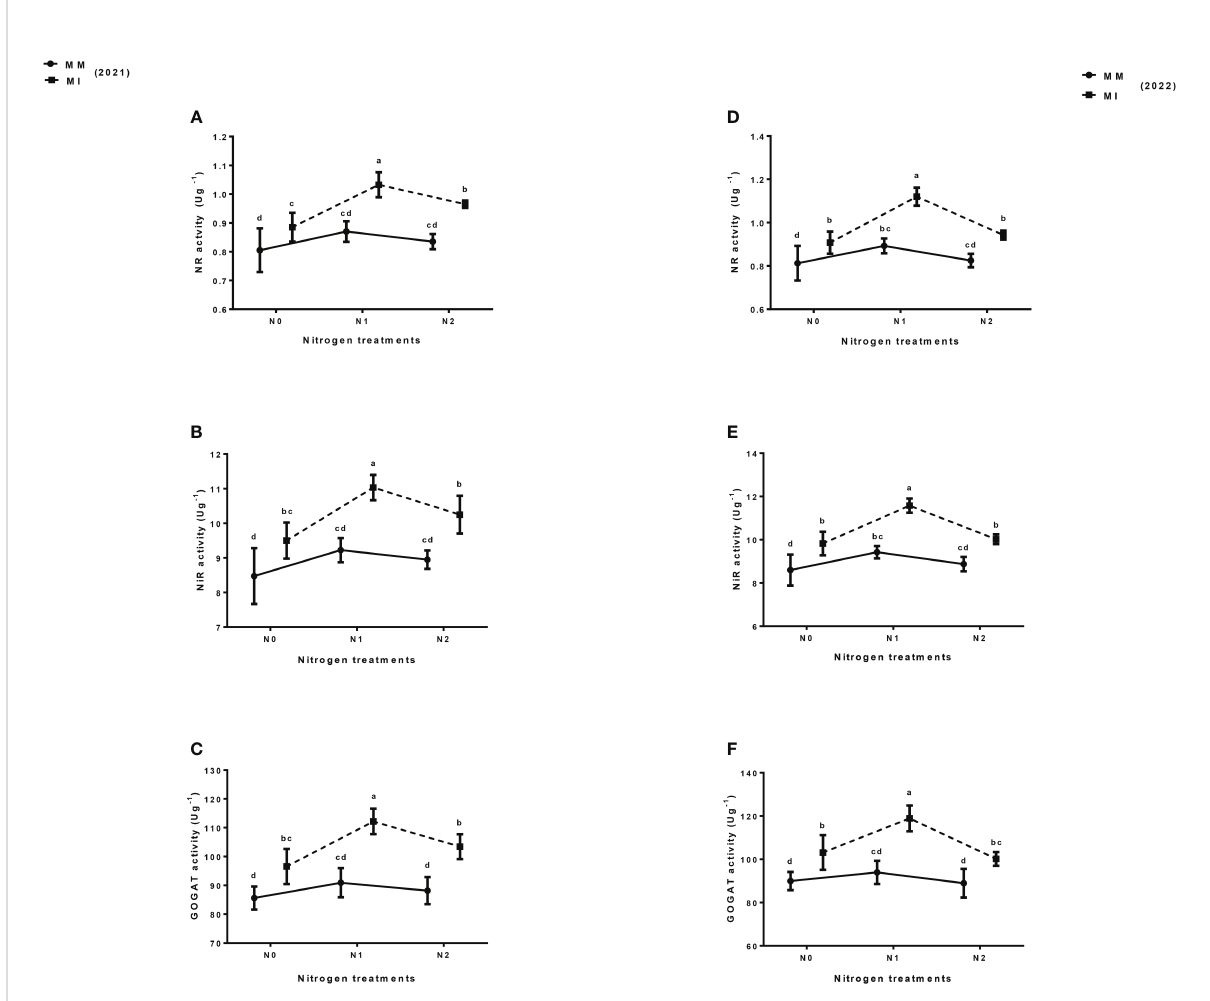
FIGURE 6 Maize nitrogen assimilatory enzymes: nitrate reductase (NR) (A, D) , nitrite reductase (NiR) (B, E) and glutamate synthase (GOGAT) (C, F) activity under different planting patterns (MM, maize mono-cropping and MI, maize intercropping) and N fertilizer application rates (N 0 ; 0 kg N ha -1 , N 1 ; 250 kg N ha -1 and N 2 ; 300 kg N ha -1 ) in 2021 and 2022 crop growing seasons. The column bars with dissimilar lowercase letters are signi fi cantly different from each other as per the LSD test ( p <